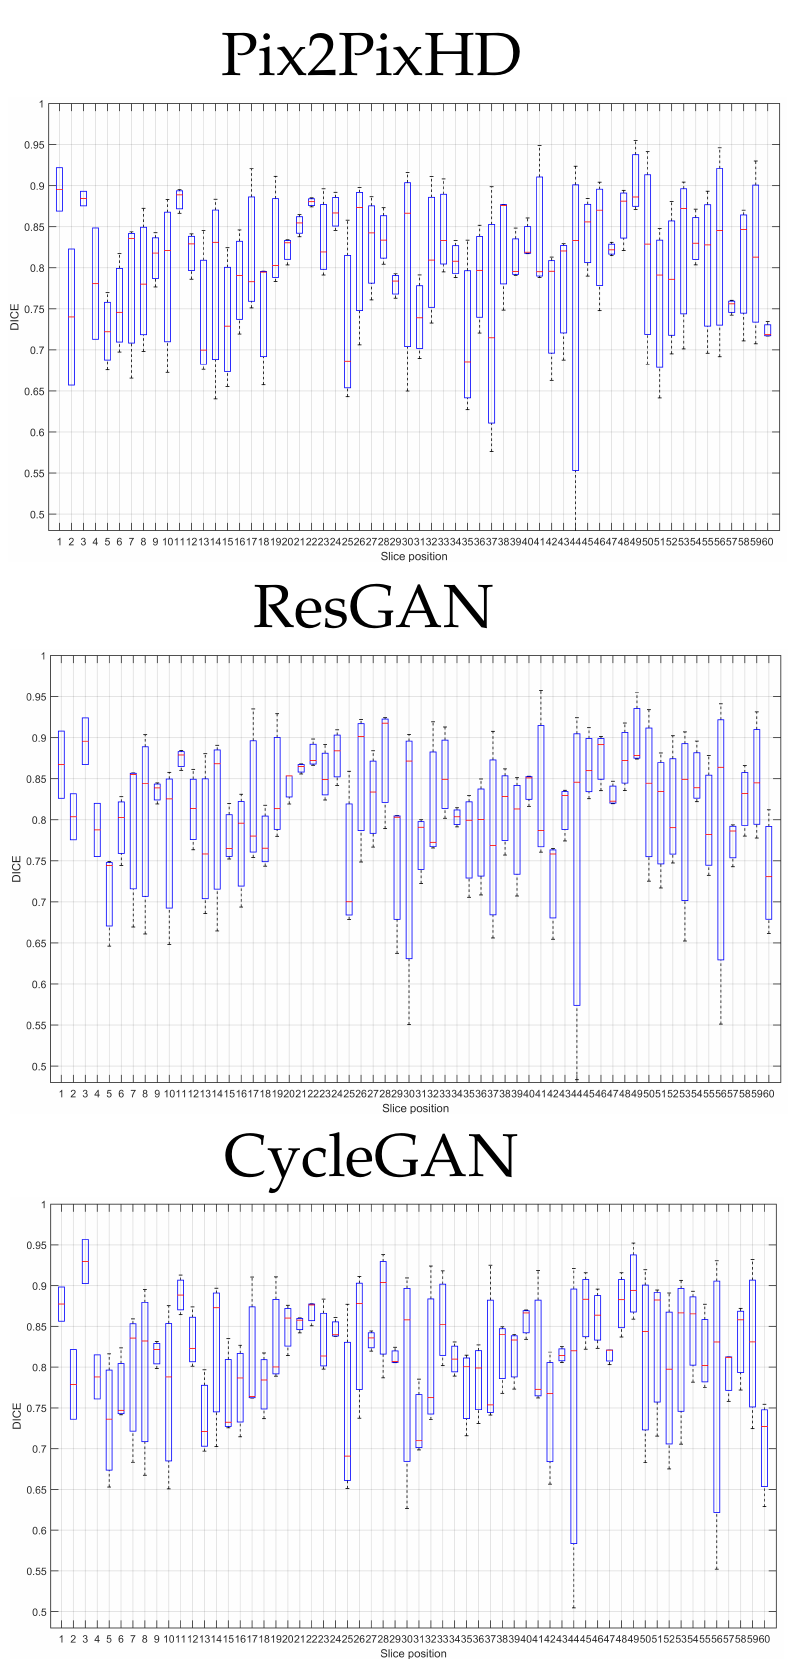
Figure 10. Segmentation test set DICE results by slice